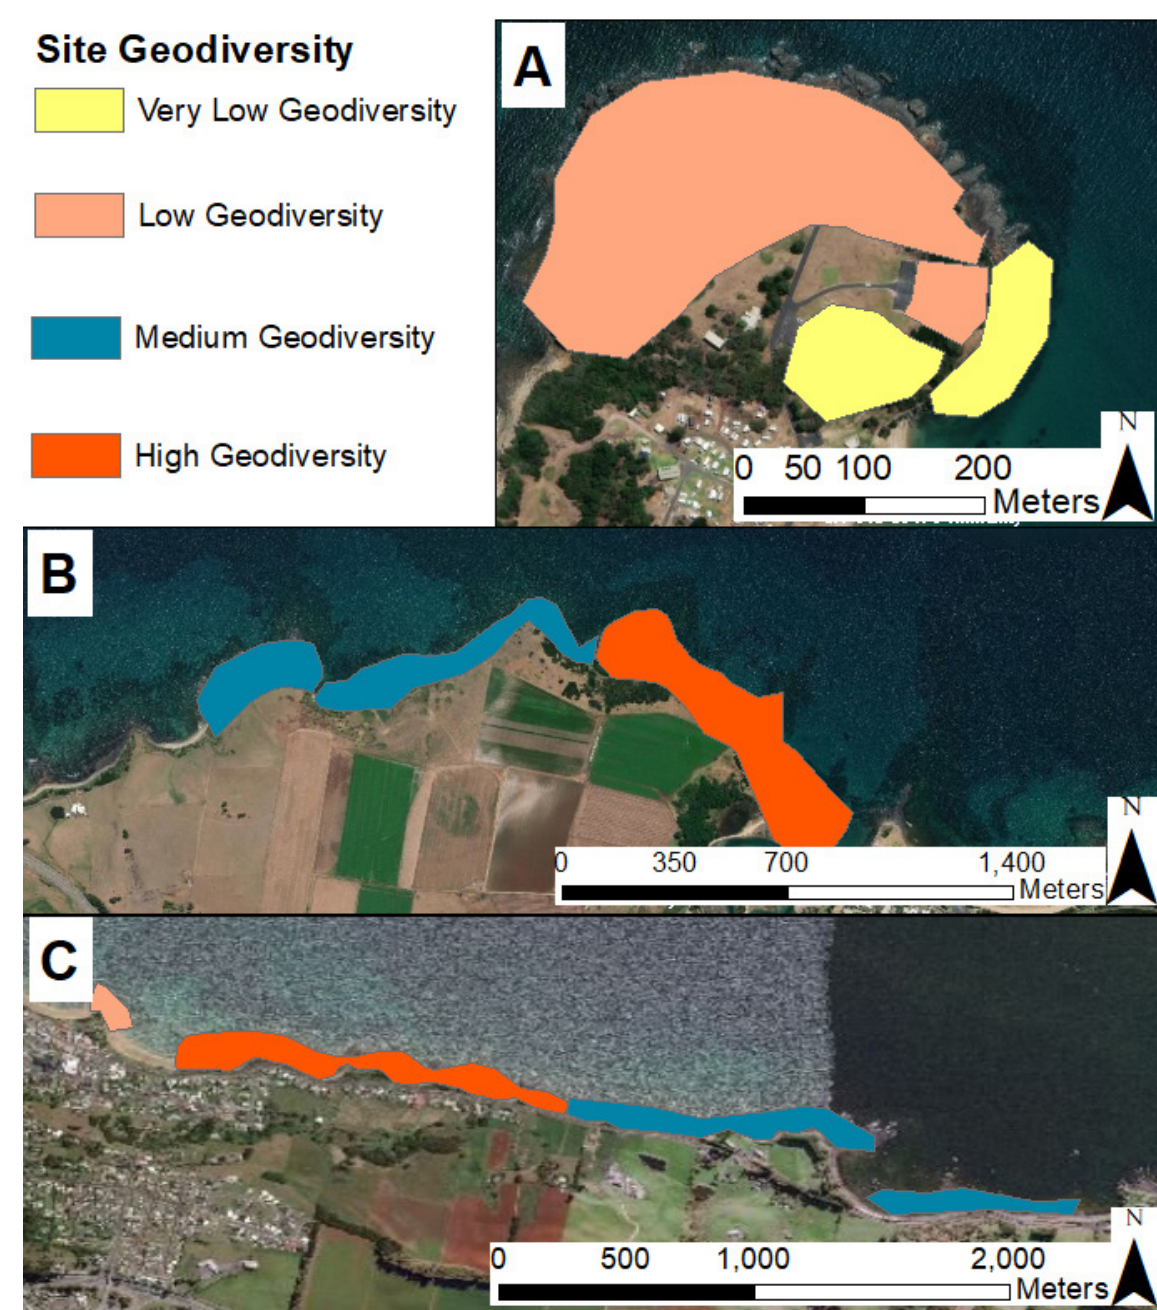
Figure 3. The calculated geodiversity value within geoconservation and validation boundaries. A) Mersey Bluff Pseudo Petro- glyph geoconservation site. B) Don Heads Basalt Landform geoconservation site. C) Penguin Megabreccia geoconservation